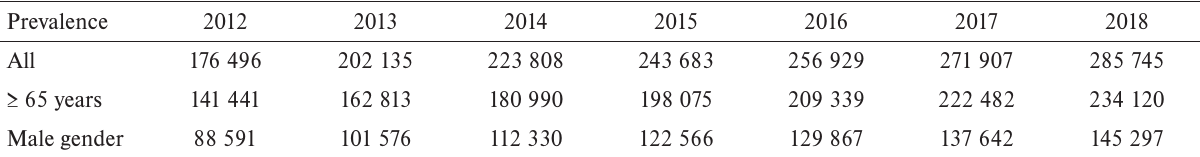
Table 1. Baseline epidemiological characteristics of HF